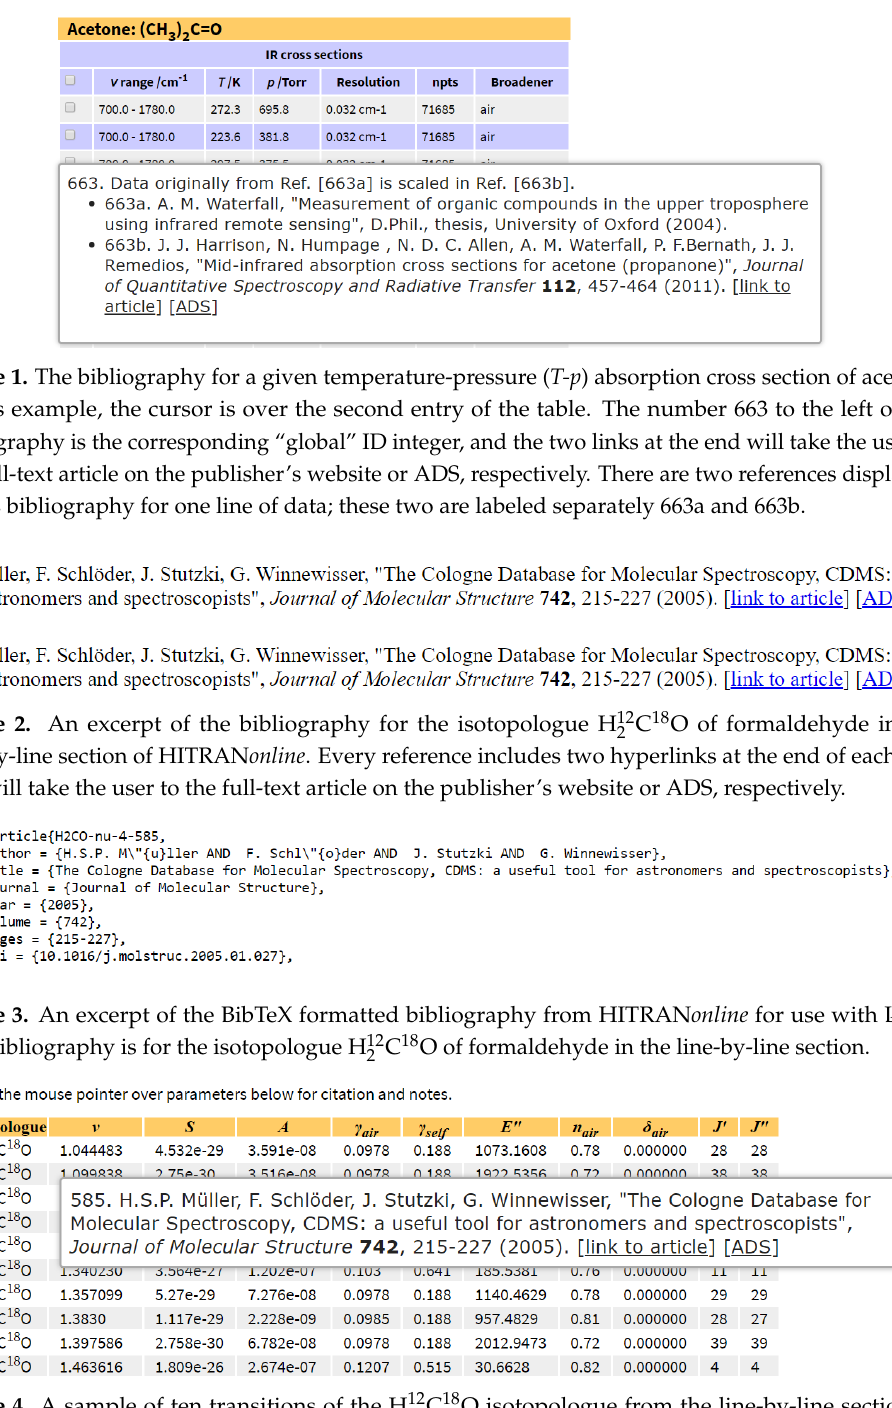
Figure 4. A sample of ten transitions of the H 12 C 18 O isotopologue from the line-by-line section of 2 HITRAN online . This HTML table is displayed when there are fewer than 1000 transitions returned by the query. A bibliography pop-up will appear for each parameter when the user hovers their cursor over the corresponding data. In this example, the cursor is over the wavenumber ( ν ) of the first